Question: Briefly state, in one sentence, what is plotted here.
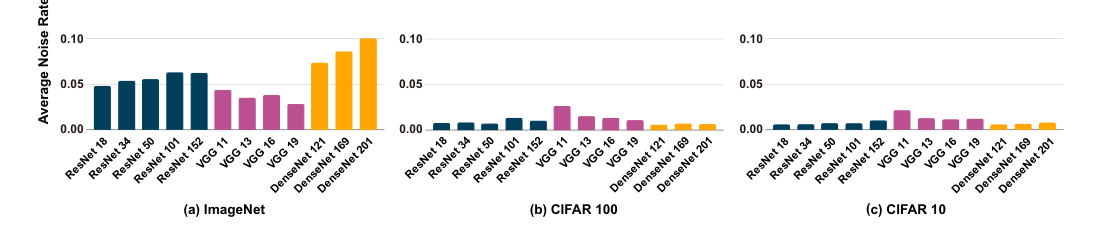
Answer: The impact of datasets on needed noise for SimBA, HopSkipJump, and Boundary attacks to succeed against 12 models from VGG, ResNet, and DensNet families. HopSkipJump and Boundary Attack seem to be more successful when the number of classes and input size are smaller. SimBA requires more noise against models trained on CIFAR-10 and CIFAR-100.